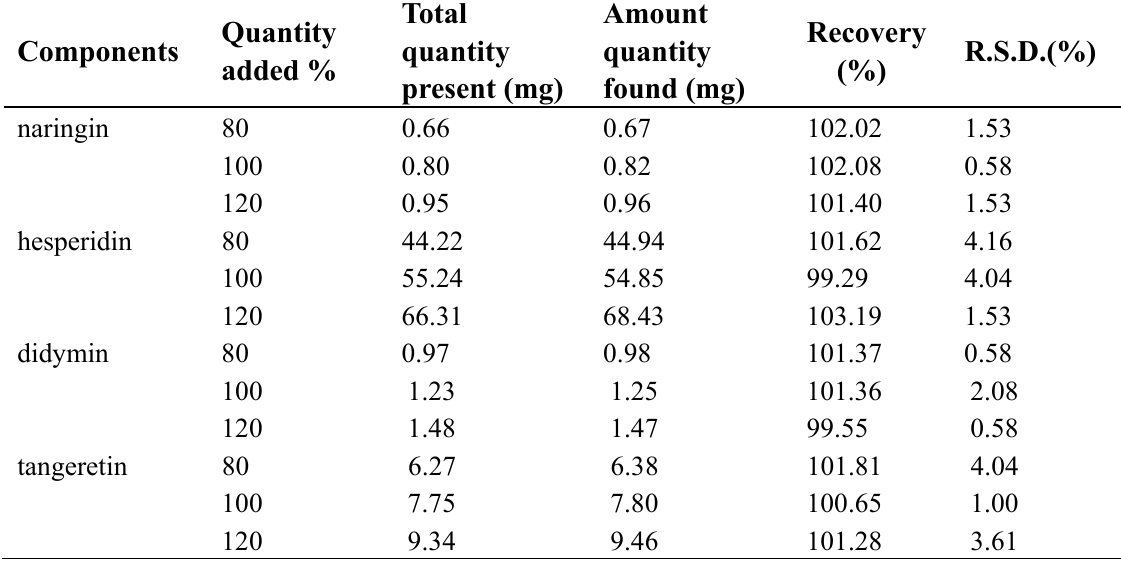
Table 2. Recovery test of the five flavonoids from peel ( n =